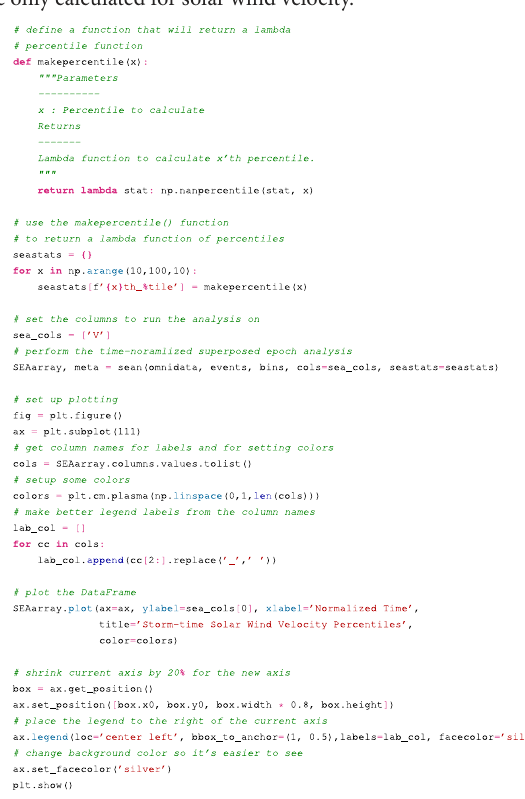
for loop. The seastats variable is assigned to a dictionary containing ten lambda functions, which are input into sean() via the seastat parameter.Tospeeduptheanalysis,thedeciles are only calculated for solar wind velocity.